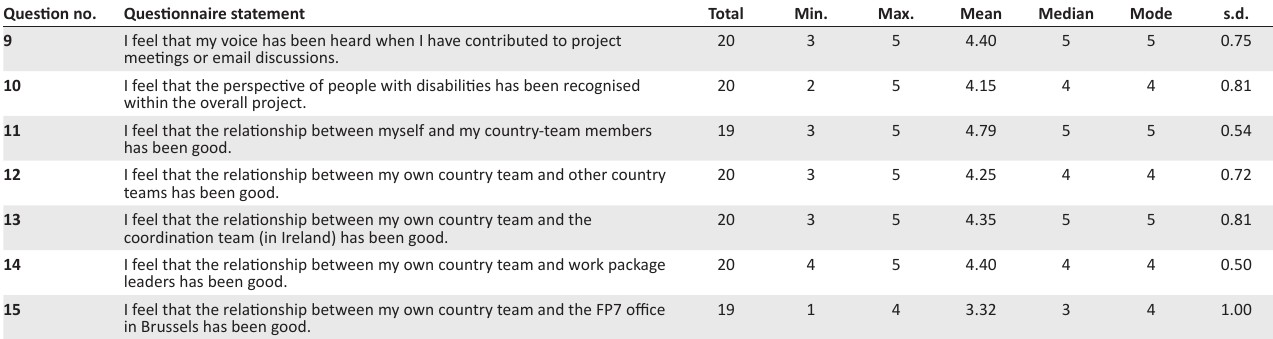
TABLE 3: EquitAble process issues.